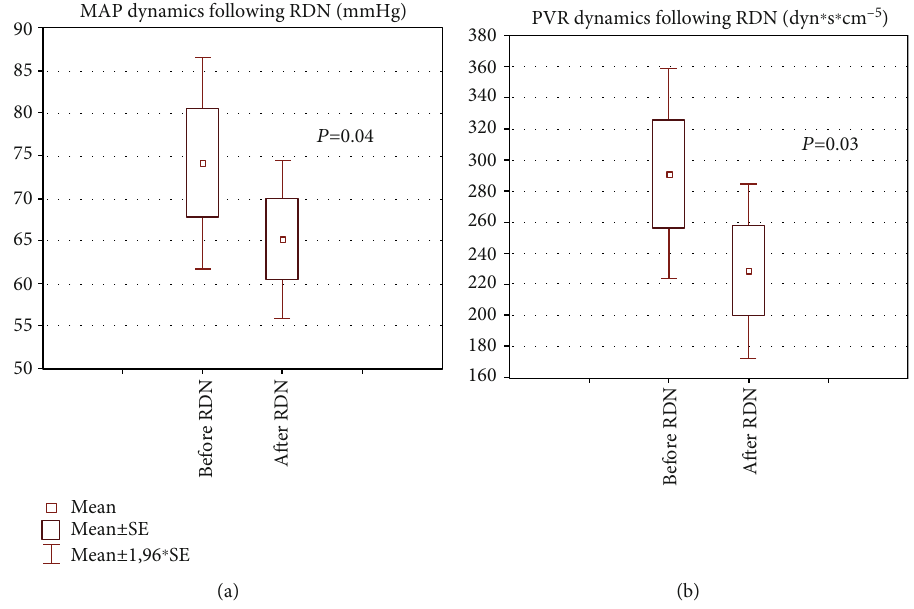
Figure 2: Hemodynamic parameters before and after RDN in fi ve animals with a decrease in MAP values. (a) Mean arterial pressure before and after ablation. (b) PVR before and after ablation. RDN: renal artery denervation; PVR: pulmonary vascular resistance.